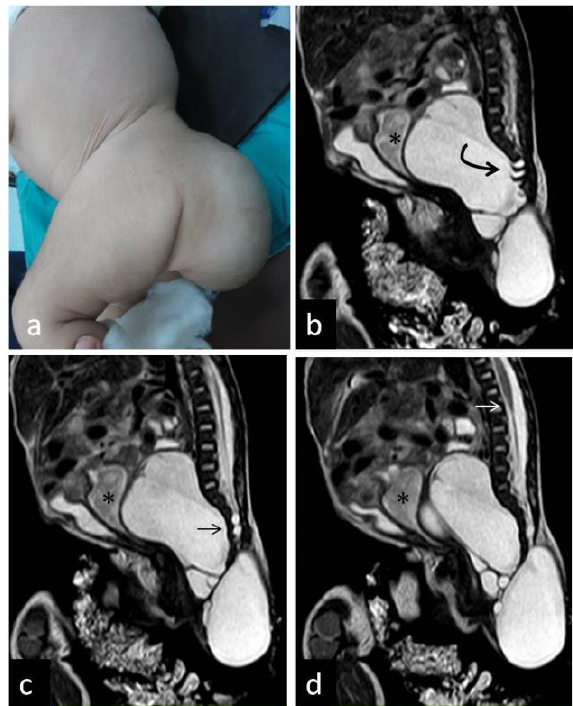
Figure 3: Mid sagittal MRI of 4 cases of SCT demonstrating the different grades of deep tumor extension in relation to the vertebral column (an asterisk * is marking for the first sacral vertebra S1). a) Tumor extension opposite to the coccyx in a one-day-old female. b) Tumor extension up to S4 (lower sacral) in a 25-month-old female. c) Tumor extension up to S1 (upper sacral) in a 12-month-old female. d) Tumor extension up to T12-L1 (abdominal) in a 25-day-old female.